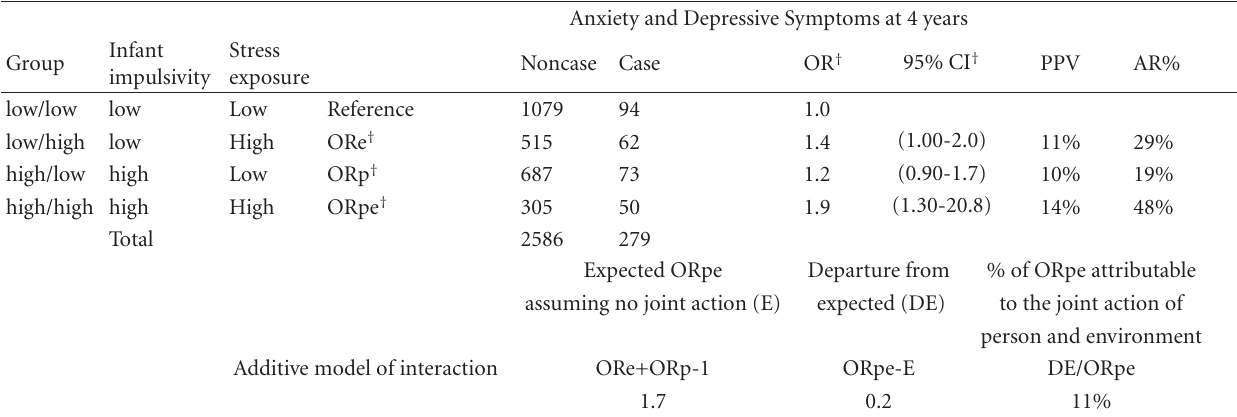
Table 5: Odds ratios for anxiety and depressive symptoms at age 4 years attributable to person-environment interaction between early life stress and impulsive temperament